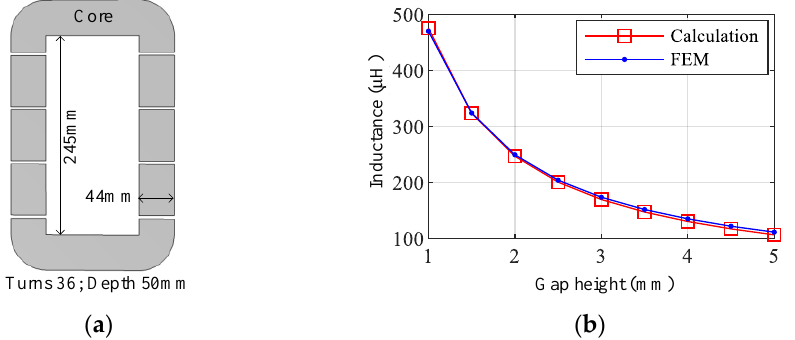
Figure 12. Calculation and simulation of the additional leakage inductance. ( a ) FEM model ( b ) com- parison of the calculated and simulated values.